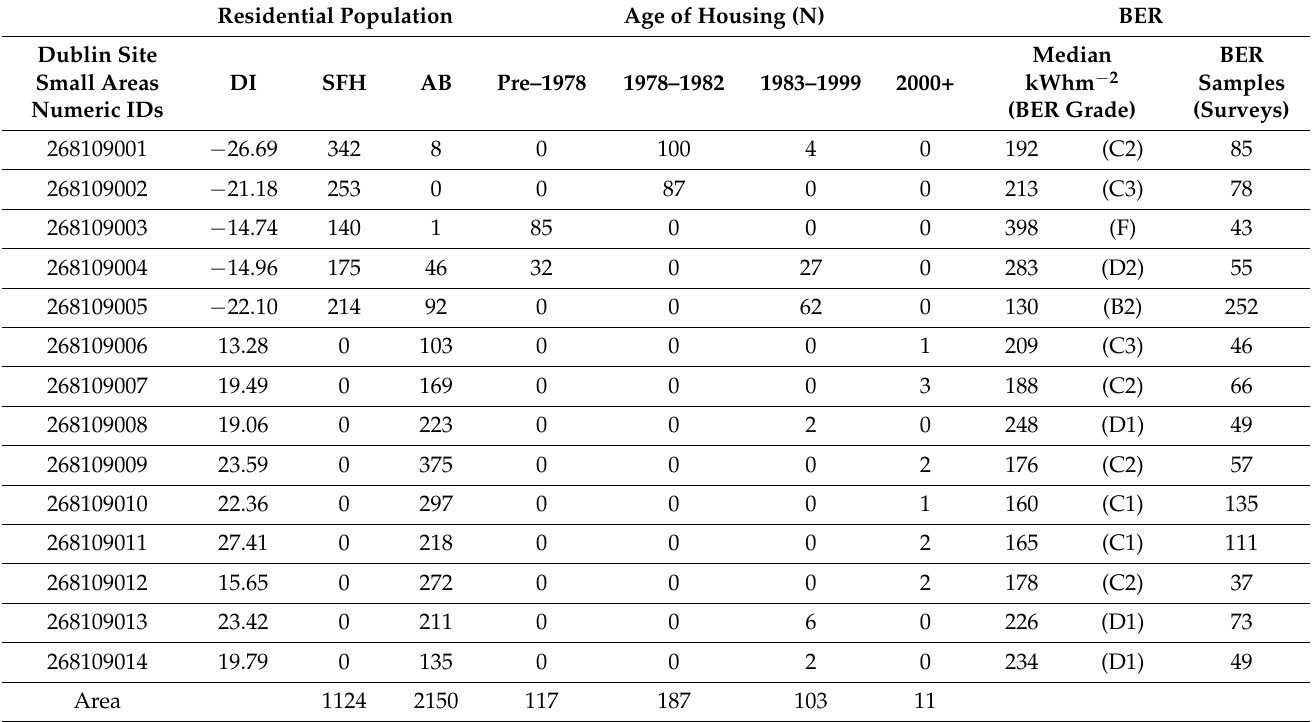
Table 1. A list of the census areas within the study area, alongside information based on the 2016 household census, the age of housing from building archetype classification and BER (https://www.seai.ie/publications/Your-Guide-to- Building-Energy-Rating.pdf accessed on 1 April 2021). The census information identifies the relative deprivation score, and the population in single family homes (SFH) and apartment blocks (AB). The age of buildings is categorised by age of construction. The BER information is based on surveys that are required of dwellings sold or rented (there are many dwellings within an apartment